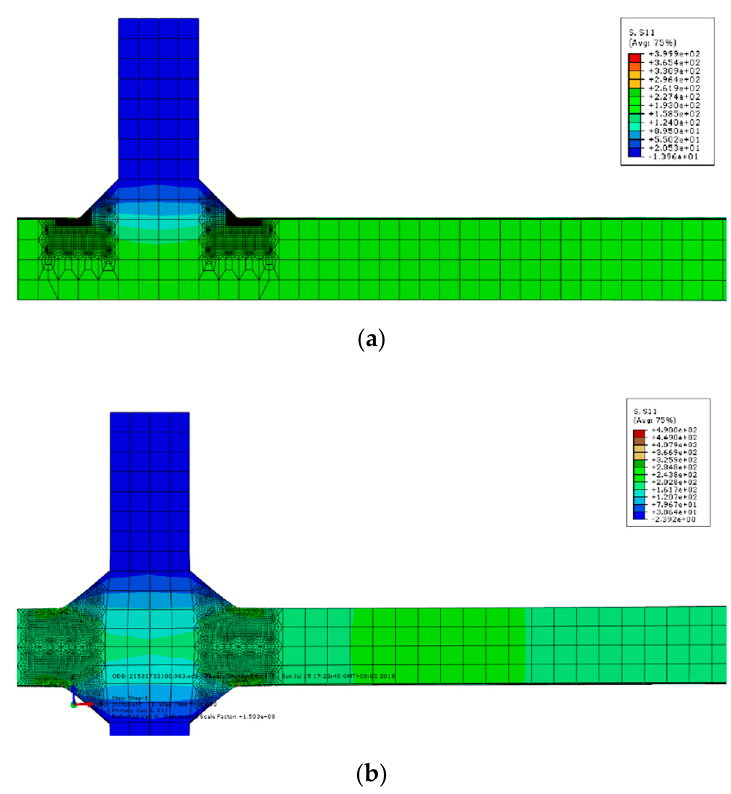
Figure 11. The distribution of stress: ( a ) T-welded joints and ( b ) cruciform welded joints.